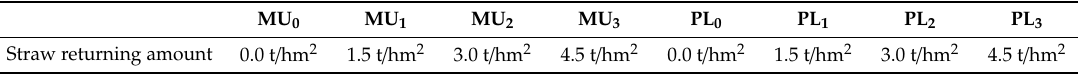
Table 1. Detailed information on oilseed rape straw